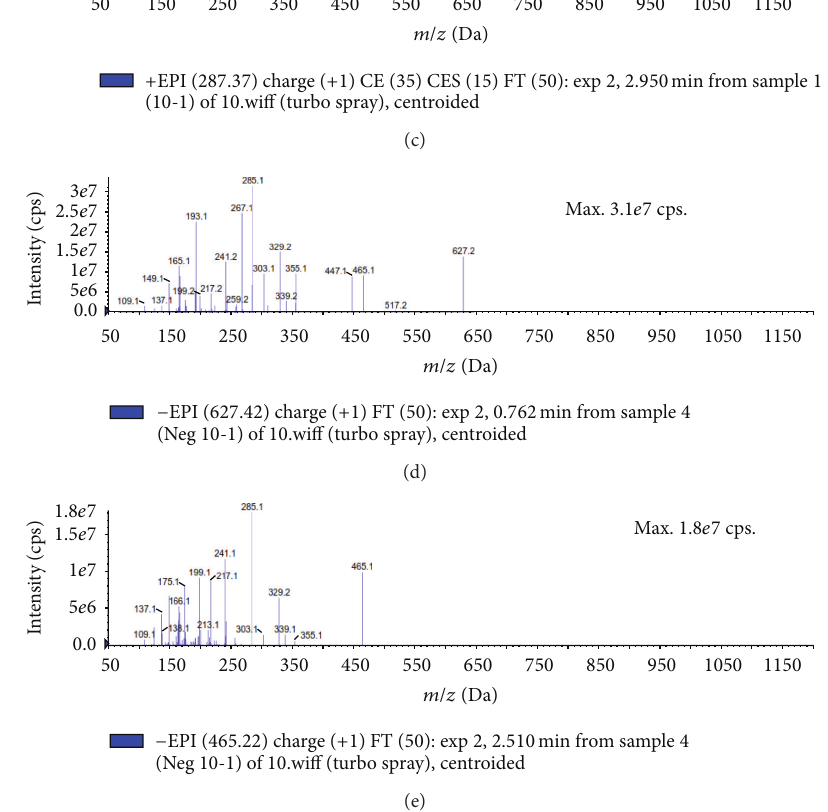
Figure 5: Mass spectra of anthocyanin-rich extract after gel filtration using Sephadex LH-20: (a–c) positive mode and (d-e) negative